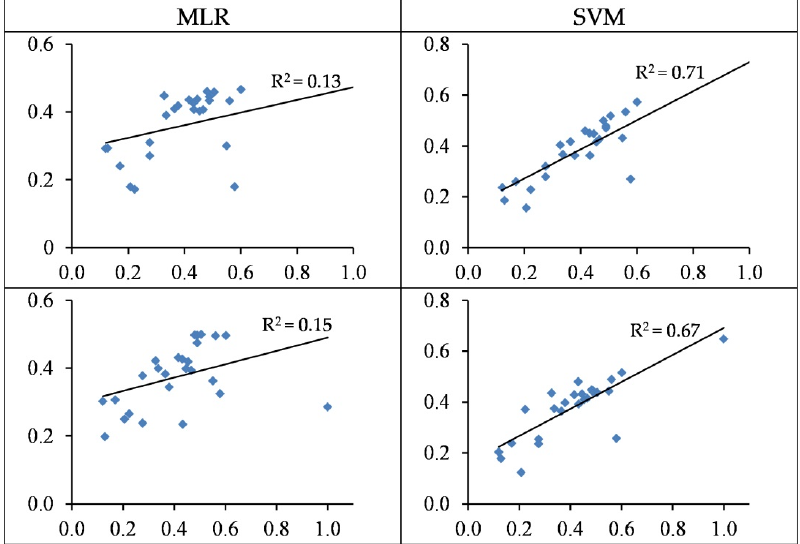
Figure 7. The standardized values (between 0–1) of the observed (horizontal axis) and the predicted (vertical axis) concentration of Pb based on wavelengths (top) and spectral indices (bottom) in the testing sets of the SVM and MLR methods.